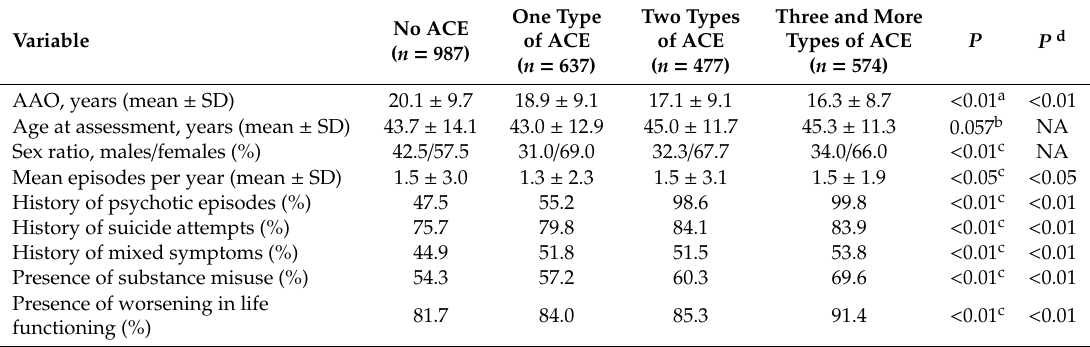
Table 4. Comparison of demographic and clinical variables between groups with no adverse childhood experiences and one, two, and three or more types of adverse childhood experiences, defined according to CLES.